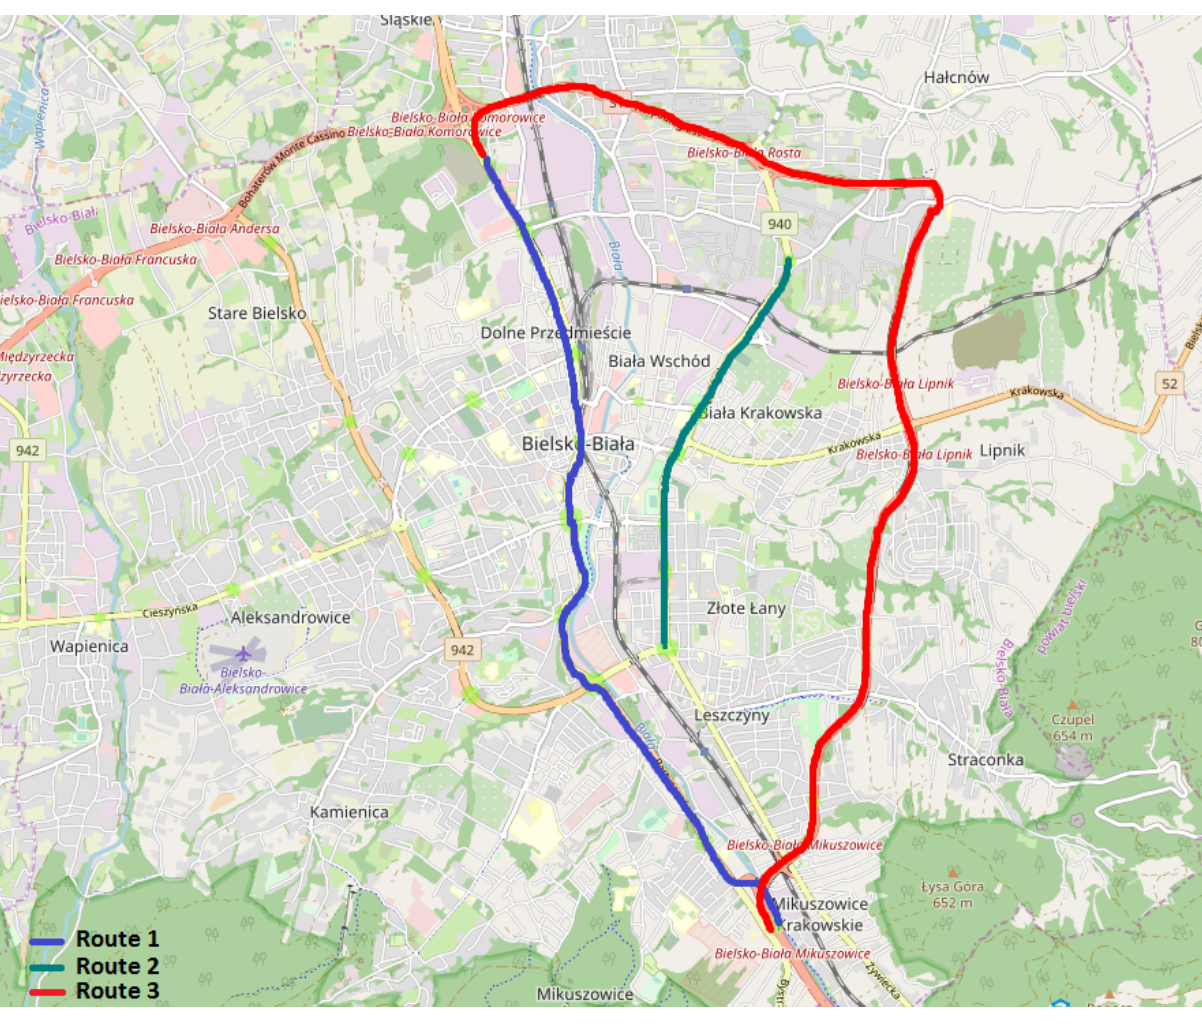
Figure 11: Selected routes of OnDynamic system in the area of Bielsko-Biala